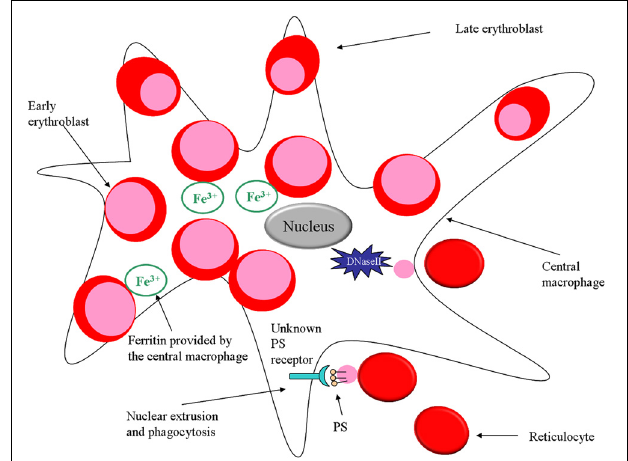
FIGURE 1 | Role of macrophages in erythropoiesis. In the erythroid niche, macrophages not only provide iron for developing erythroblasts but also phagocytose expelled nuclei. Furthermore, the macrophage protein DNaseII is important for breakdown of nuclei that are expelled by